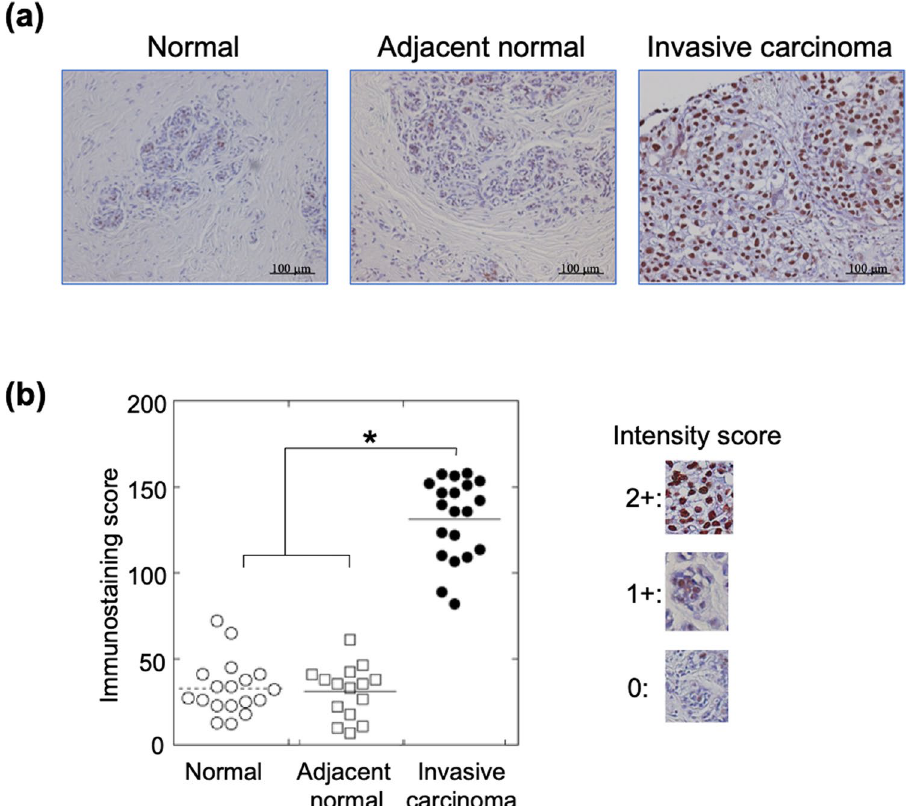
Figure 1. Immunohistochemical analysis of breast cancer tissue array. ( a ) Strong expression of SET was detected in nuclei of invasive carcinoma, but not in those of normal and adjacent normal tissues. ( b ) Immunostaining scores were determined as described in “Methods” section. Invasive carcinoma tissues showed significantly higher score than those of normal and adjacent normal tissues. * P < 0.01.